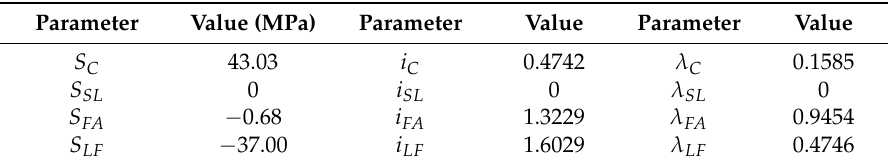
Table 5. Optimal parameters of CCSDOT model.